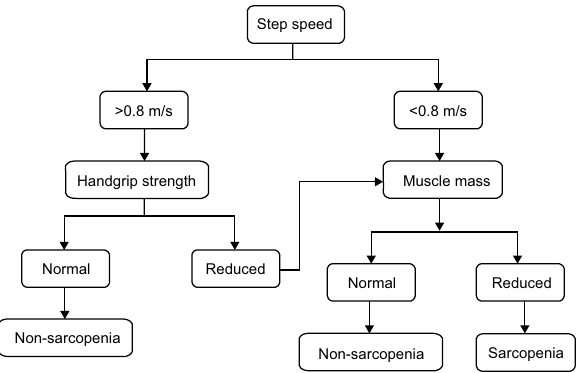
Figure 2. Flow chart of sarcopenia screening and assessment.